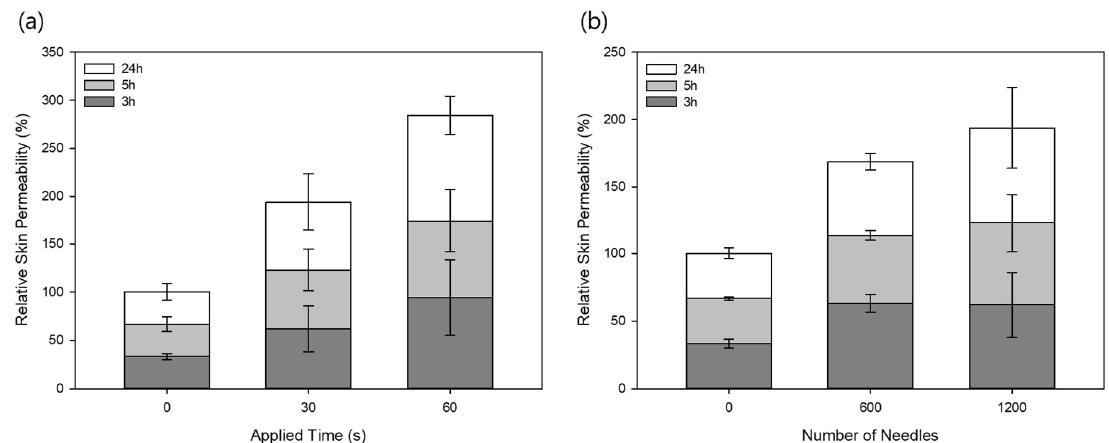
Figure 6. Relative skin permeability of niacinamide after ( a ) applying 1200 MLPs for 30 and 60 s. The same experiment was performed again using niacinamide to determine the relative skin permeability after ( b ) applying 300 and 600 MLPs for 30 s (means ± SD, n = 3).